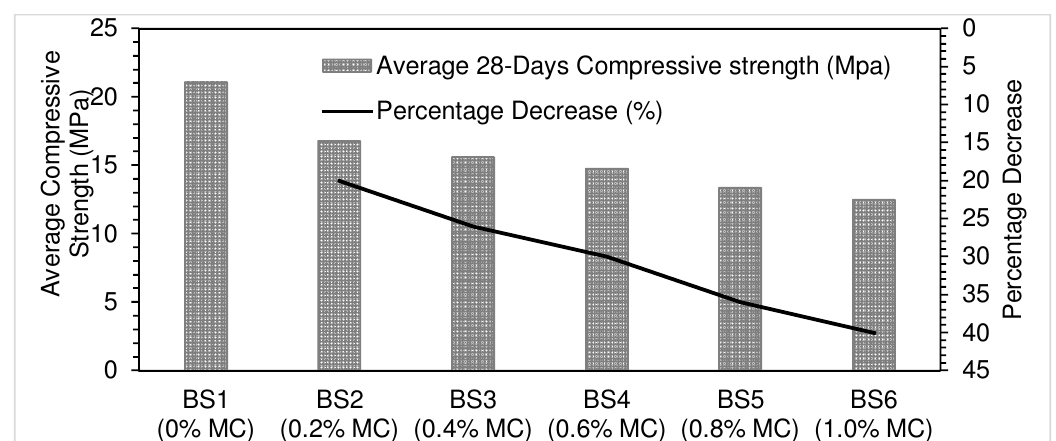
In case of cylinder specimen, on addition of 0.2% MC the concrete compressive strength increased from 19.74 MPa to 19.85 MPa which is insignificant. But on addition of 0.4% and 0.6% MC the strength increased to 23.4 MPa and 20.3 MPa respectively. Up to MC content of 0.6% the compressive strength was observed to increase but on increasing MC beyond 0.6% the strength reduced below the control sample. strength was 19.24 MPa and 18.33 MPa respectively.